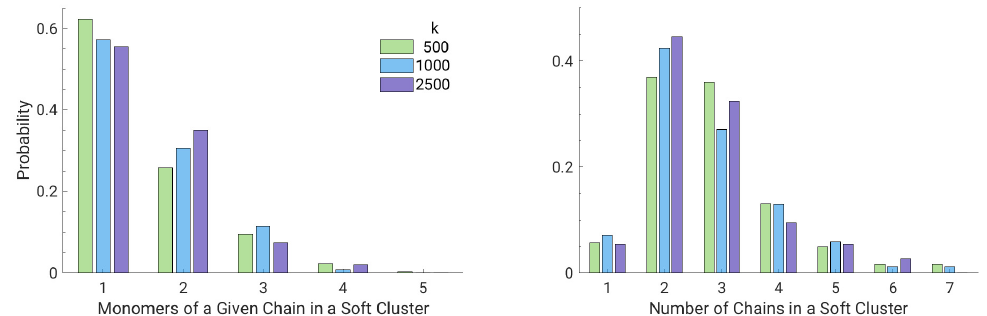
Figure 9. ( Left ) probability of having n monomers belonging to a given chain in a soft cluster. ( Right ) probability of having monomers coming from m different chains in a given soft